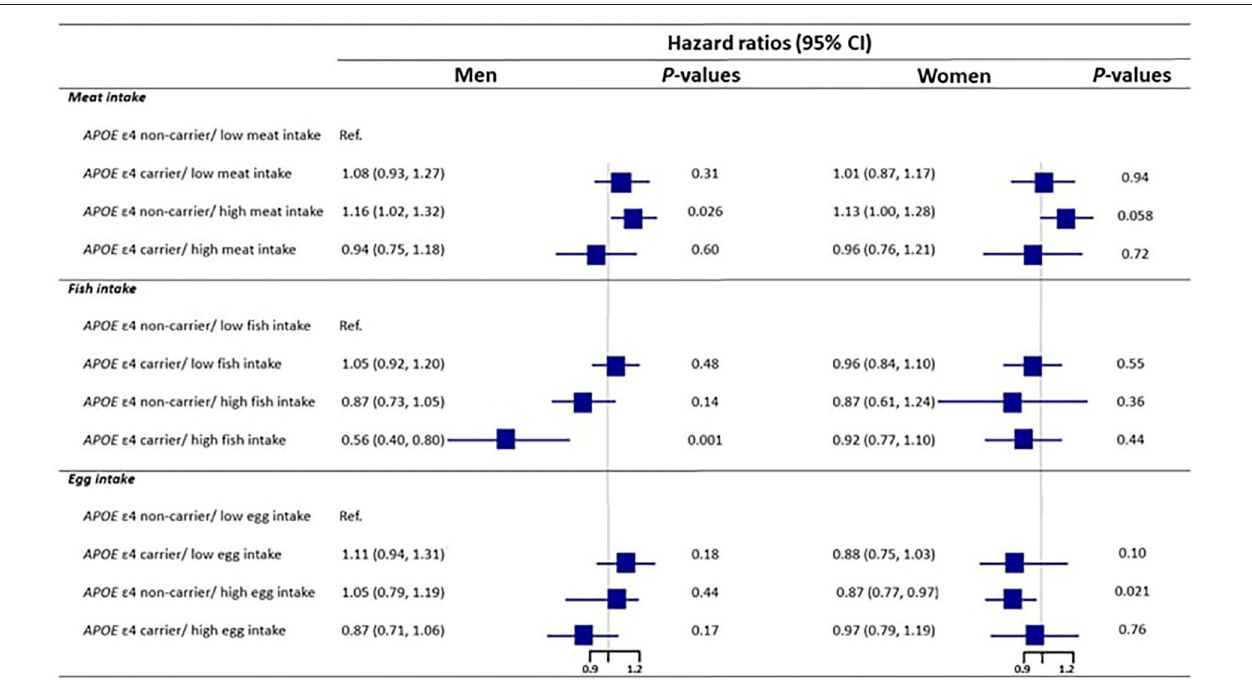
FIGURE 3 | The interaction of APOE E4 genotype with meat, fish, and egg on mortality by sex. Model was adjusted for age, sex, education, marital status, ethnicity, living arrangement, residence, occupation, other nine kind of dietary components tobacco smoking status, alcohol drinking status, current physical activity, abnormal body weight, activity of daily living, leisure activity score, mini-mental state examination score, and eight kinds of self-reported diseases (COPD, tuberculosis, cancer, cataract, glaucoma, diabetes, stroke and cardiovascular